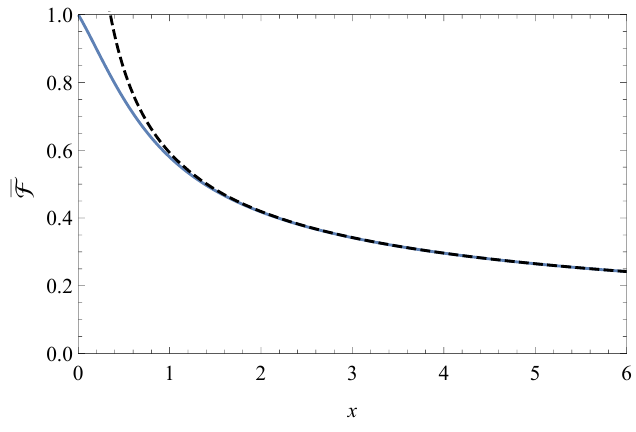
+ F ) / 2 as obtained from numerical solutions to Figure 5: Solid line: ¯ F = ( F ∞ 0 Eqs. (31) and (32); on this scale, the approximate formula in Eq. (33) is indistin- guishable from the numerics. Dashed line: the asymptotic formula 0.5927 / obtained from Eq. (33) at large x , is a good approximation for x >